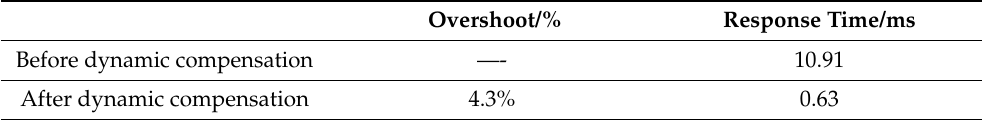
Table 4. Dynamic performance index of the magnetometer before/after dynamic compensation.